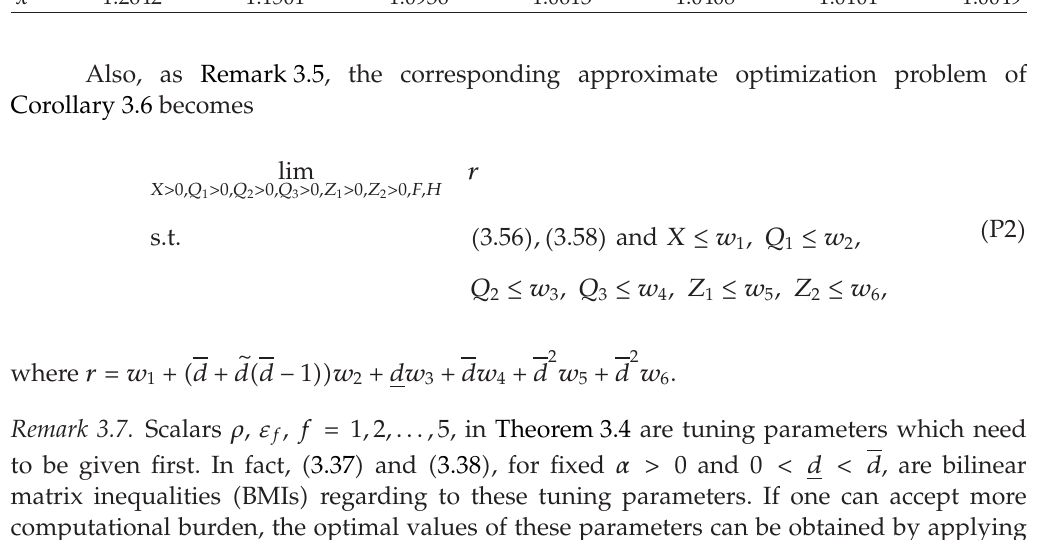
Table 1: Maximum allowable decay rates λ for di ff erent d with d (cid:9) 1. d 3